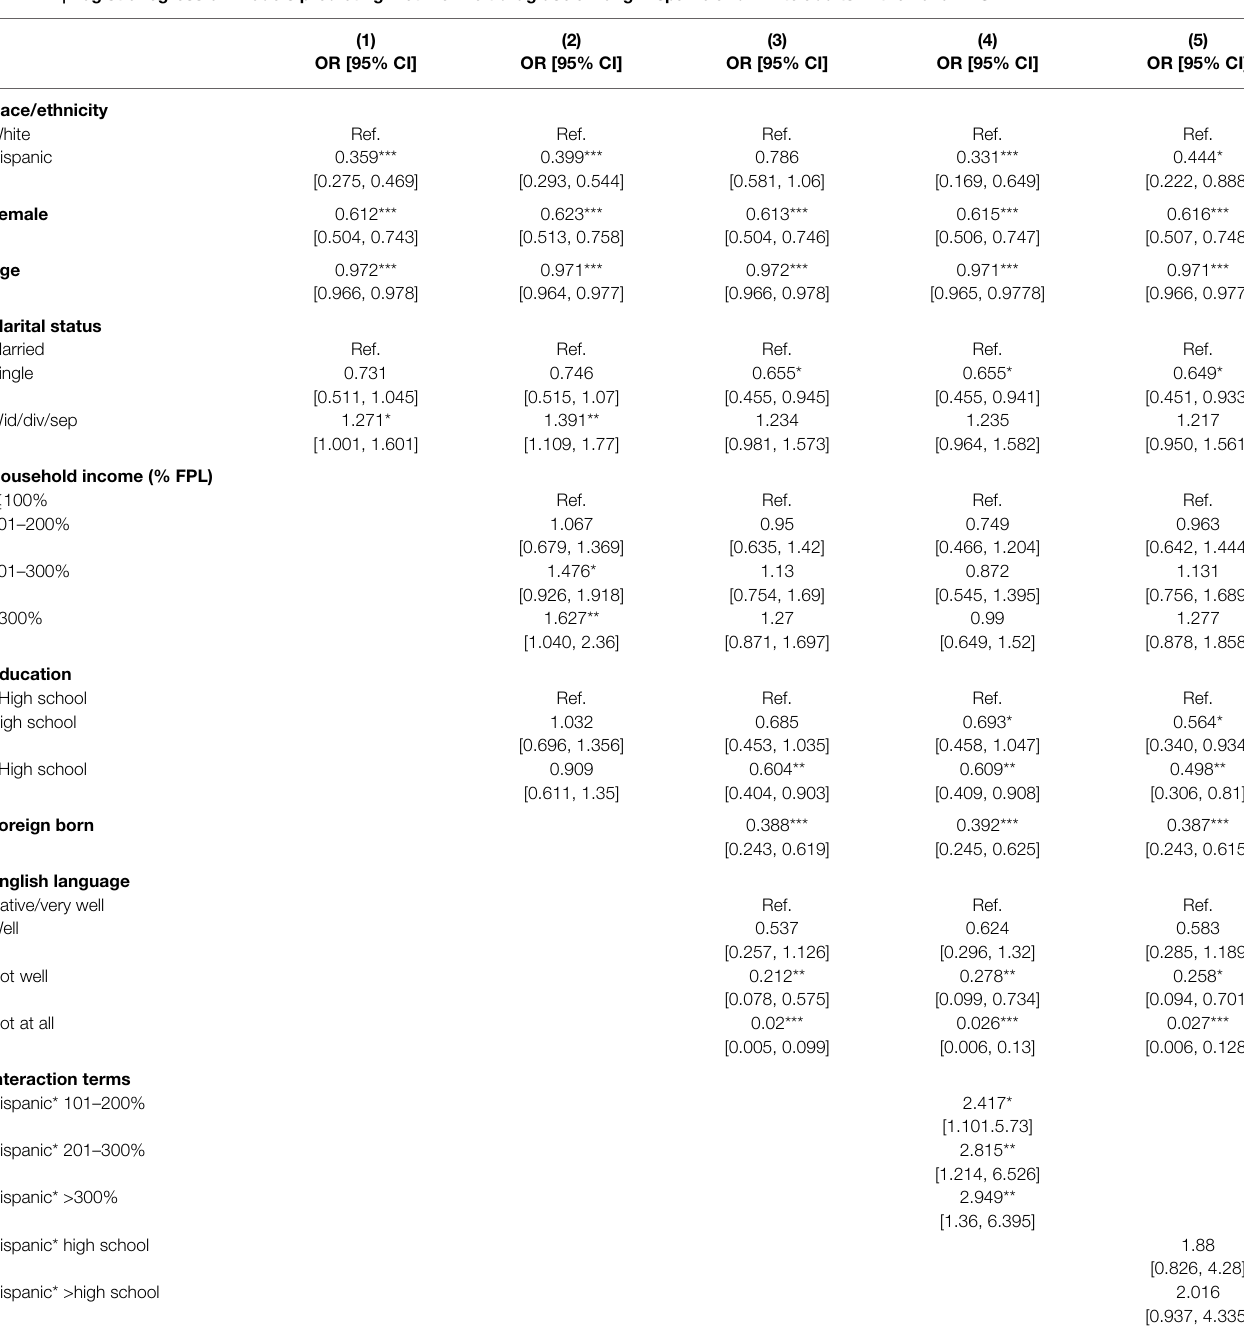
TABLE 4 | Logistic regression models predicting lifetime illicit drug use among Hispanic and White adults in the 2010 AHS